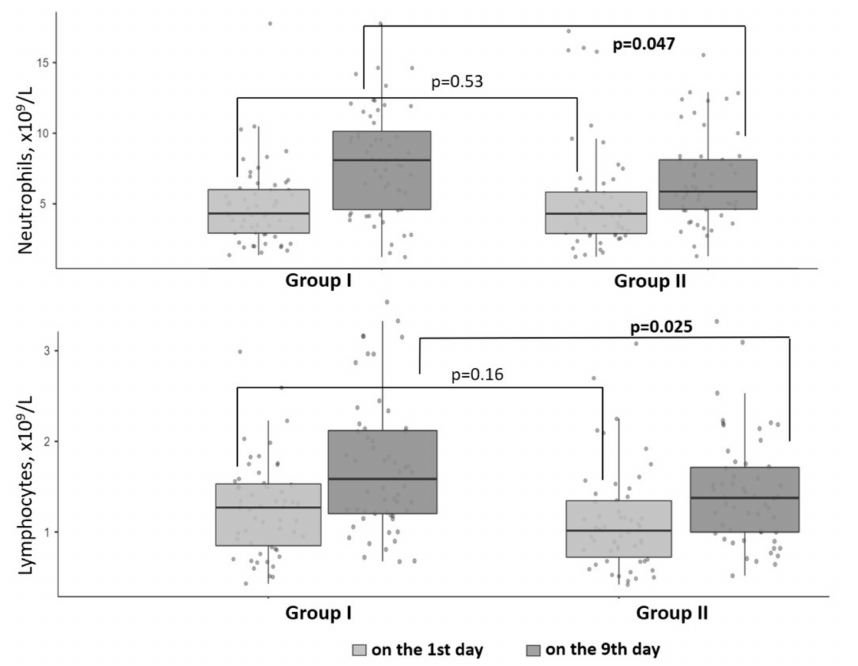
Figure 3. Neutrophil and lymphocyte counts before and after 100,000 IU cholecalciferol supplementation.